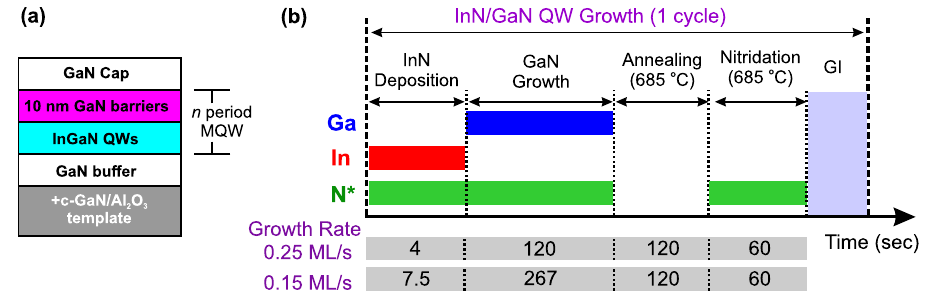
Figure 1. ( a ) Schematic of the sample structure for n = 5 (sample series A) or n = 3 (sample series B) MQWs. ( b ) Deposition sequence for the two employed growth rates. The duration of the growth interruption (GI) step was ≈8–9 min depending on